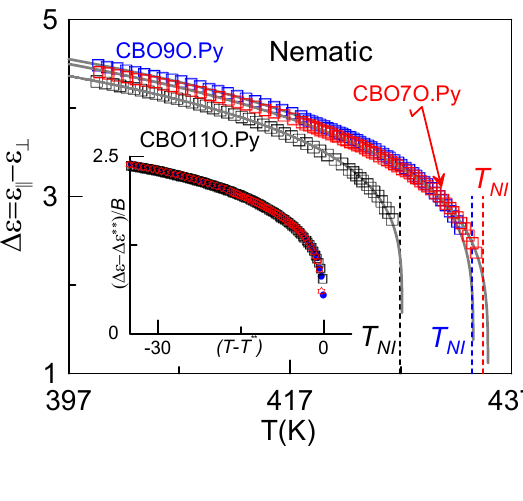
Figure 5. Dielectric anisotropy as a function of temperature for the three studied dimers. Gray solid lines are fittings according to Equation (5). The inset shows the dependence of   B / **   with the metastable region for CBO11O.Py, CBO9O.Py and